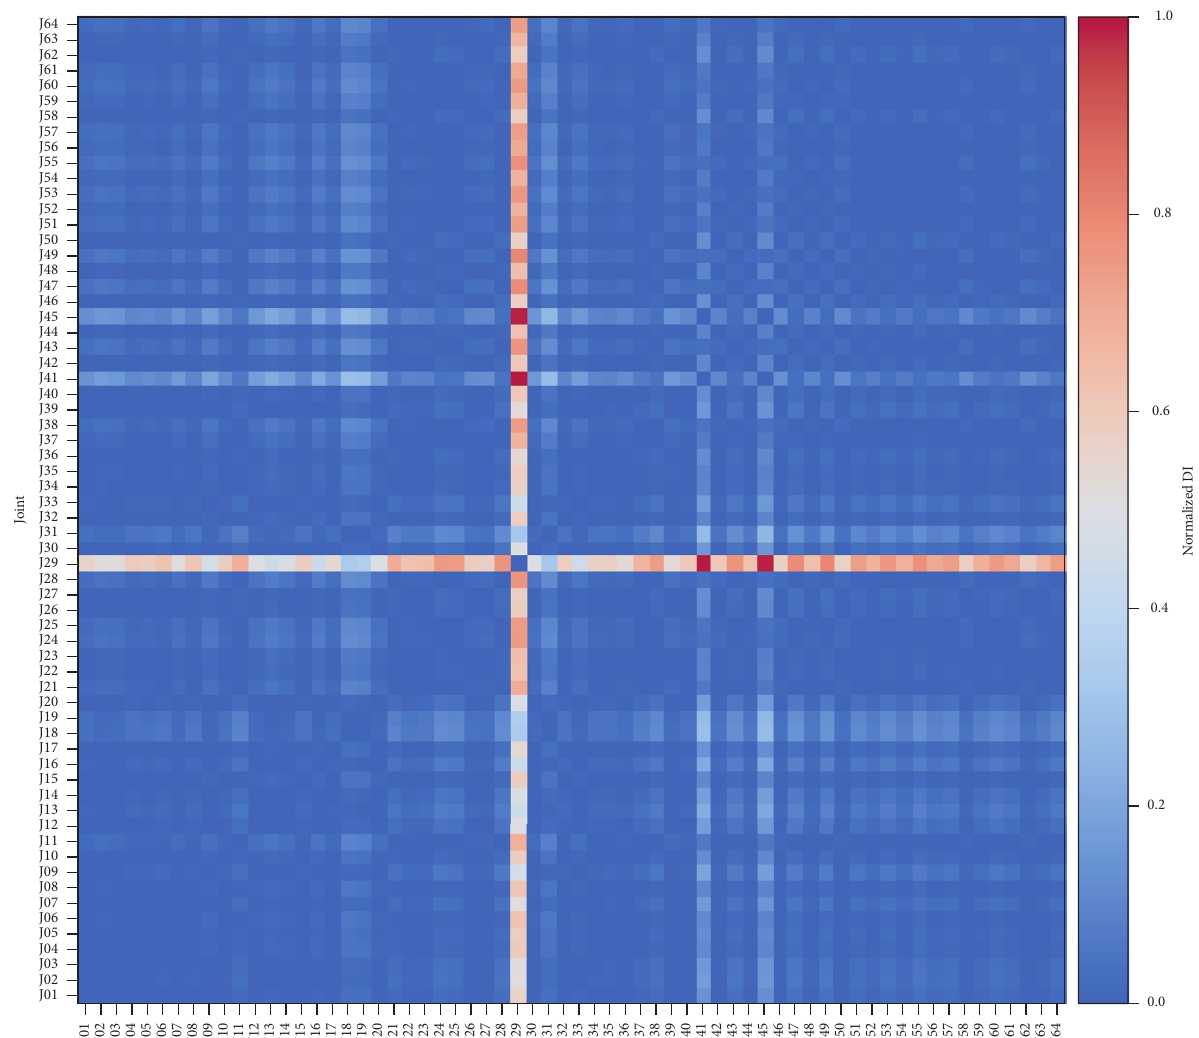
Figure 8: Normalized damage indicator